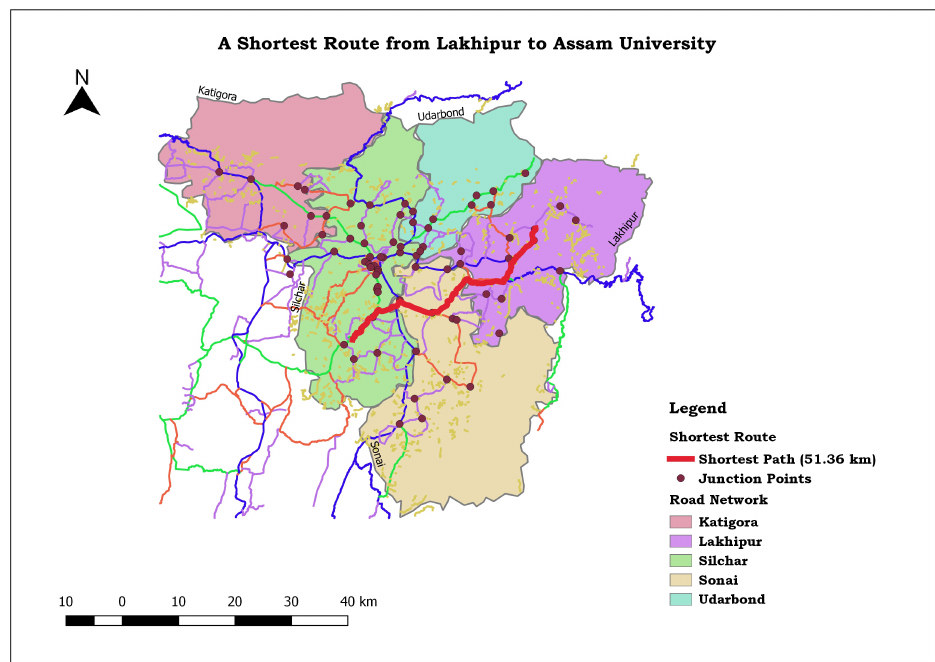
Figure 10. A shortest route from Lakhipur to Assam